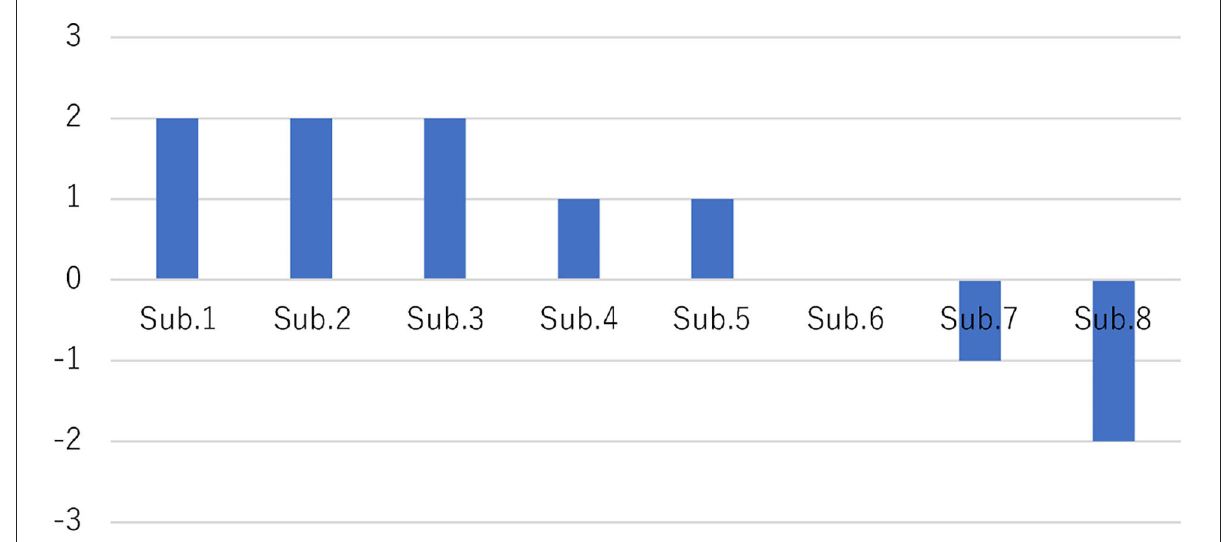
FIGURE9 Results of Experiment 2. Individual differences in changes in the fatigue perception between